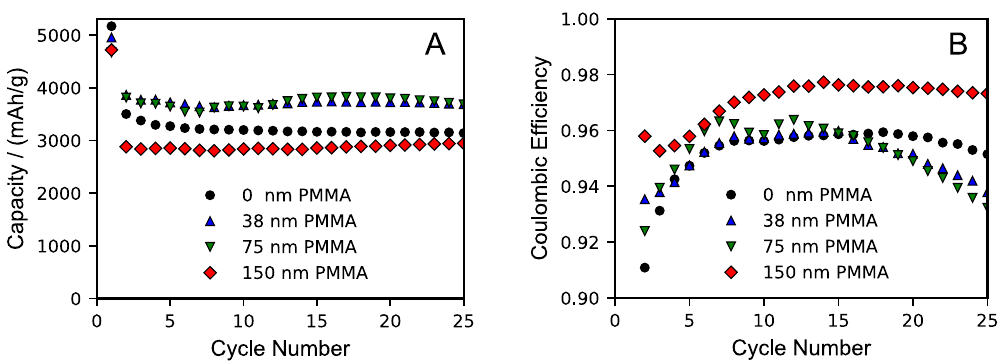
Table 2. First and average cycling data as a function of coating